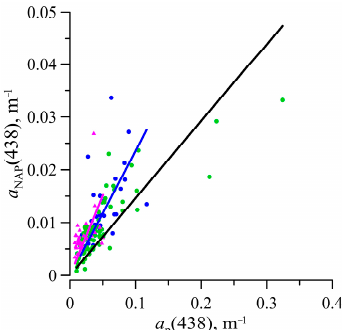
Figure 8. Relationship between light absorption coefficient of non-algal particles ( 𝑎 (cid:3015)(cid:3002)(cid:3017) (438) ) and total particulate absorption ( 𝑎 (cid:3043) (𝜆)) at 438 nm. Symbols are denoted as in Figure 5. Blue, black and purple lines denote the linear relationship for the surface ( 𝑎 (cid:3015)(cid:3002)(cid:3017) (438) = 0 .24 × 𝑎 (cid:3043) (438) r 2 = 0.83 (n = 35)), for euphotic ( 𝑎 (cid:3015)(cid:3002)(cid:3017) (438) = 0 .15 × 𝑎 (cid:3043) (438) , r 2 = 0.75 (n = 127)) and below layers ( 𝑎 (cid:3015)(cid:3002)(cid:3017) (438) = 0 .30 × 𝑎 (cid:3043) (438) , r 2 = 0.72 (n = 28)), respectively.